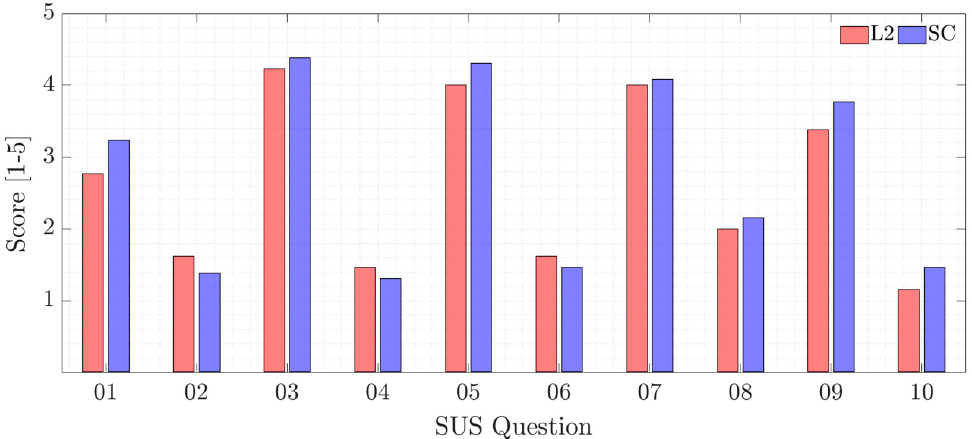
Figure 16. System Usability Scale individual questions results.